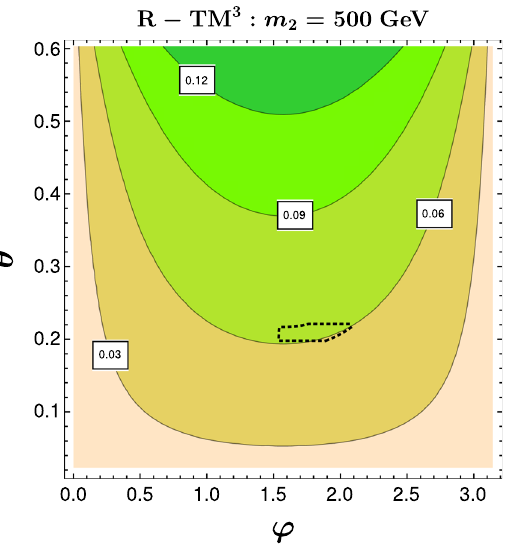
Fig. 6 Compatibility between the freeze-in DN and the neutrino oscil- lation observables for patterns TM 2 and TM 3 with a retarded-cutting scheme. The area enclosed by the black-dotted line represents the 3 σ